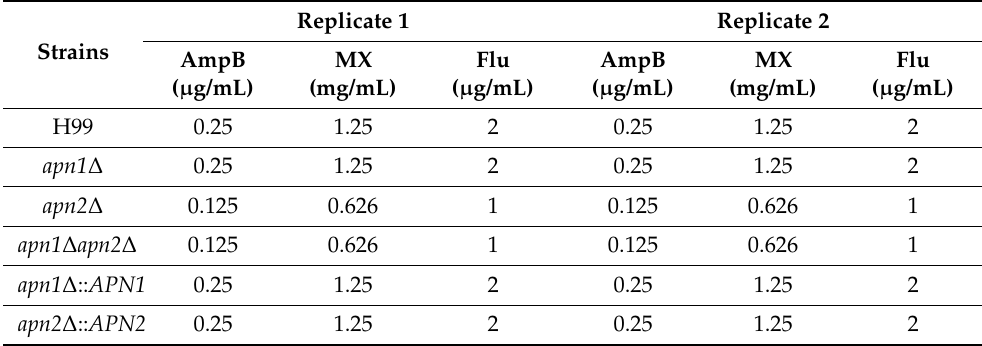
Table 1. MIC values of amphotericin B (AmpB), methoxy-amine hydrochloride (MX) and Fluconazole